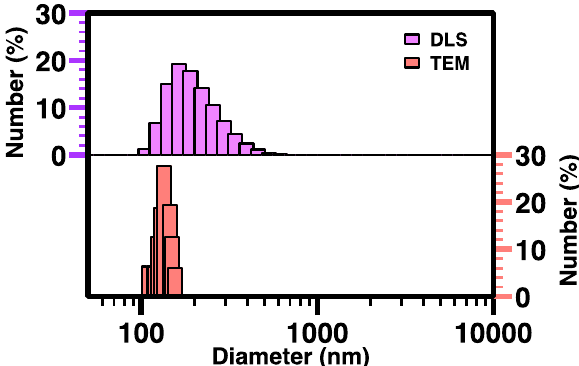
Figure 12. The number-average size distribution of PEG- b -CPCL-70:pDNA nanocomplexes at 200:1 mass ratio from DLS measurement (top) and TEM image analysis (bottom).